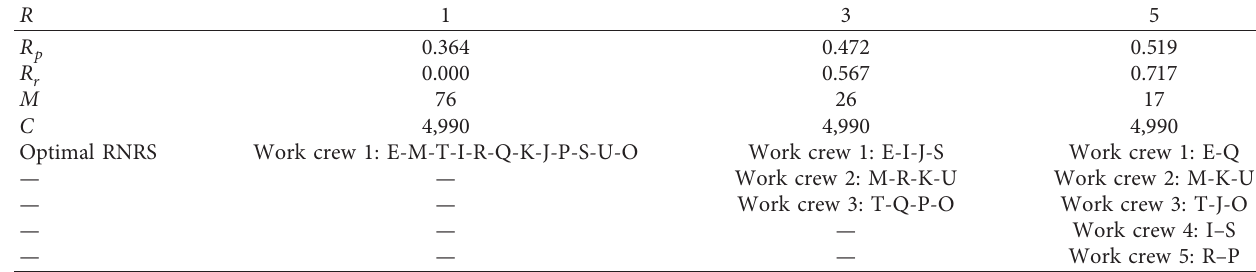
Table 5: Effect of R on the optimal RNRS.